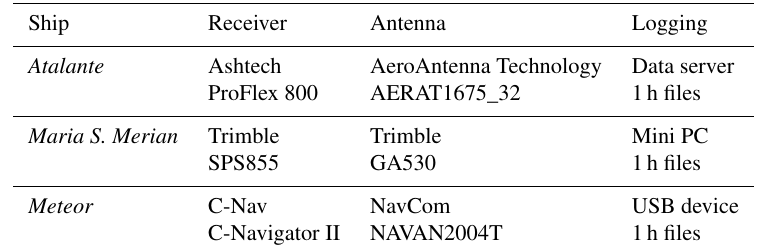
Table 1. Summary of ship-borne GNSS acquisition systems operated during EUREC 4 A. Ship Receiver